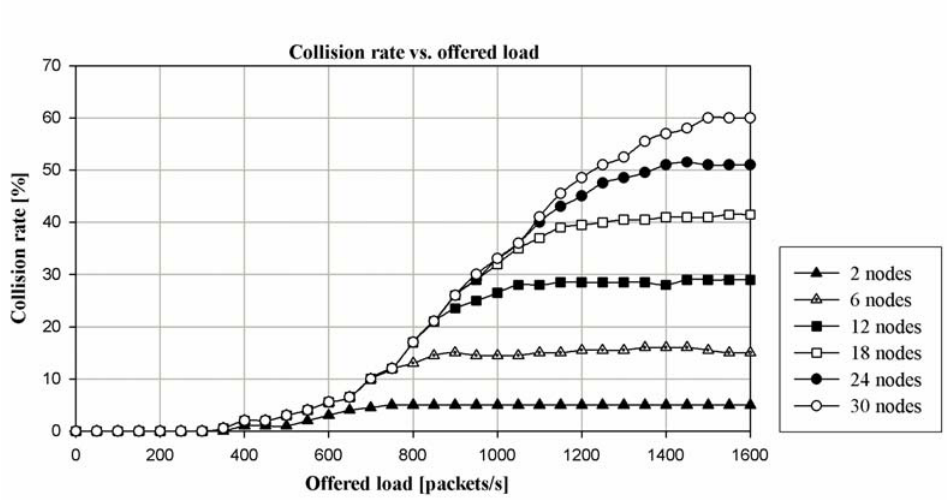
Figure 5. Collision rate versus offered load for different number of nodes (load scenario